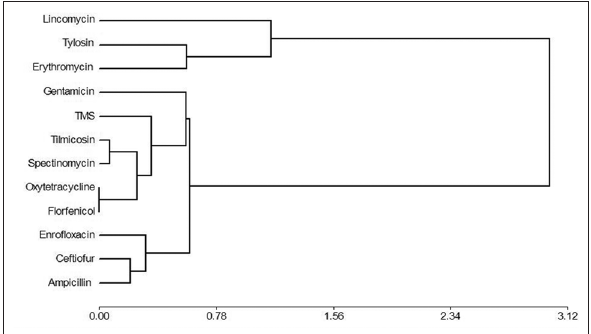
Figure-3: Dendrogram shows conglomerates analysis of antibiotic profiles of Pasteurella multocida from progressive atrophic rhinitis and pneumonic pasteurellosis